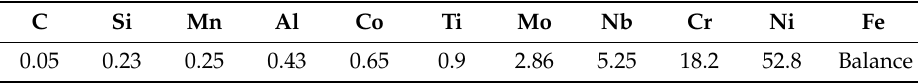
Table 1. Chemical compositions of Inconel 718 (wt %).